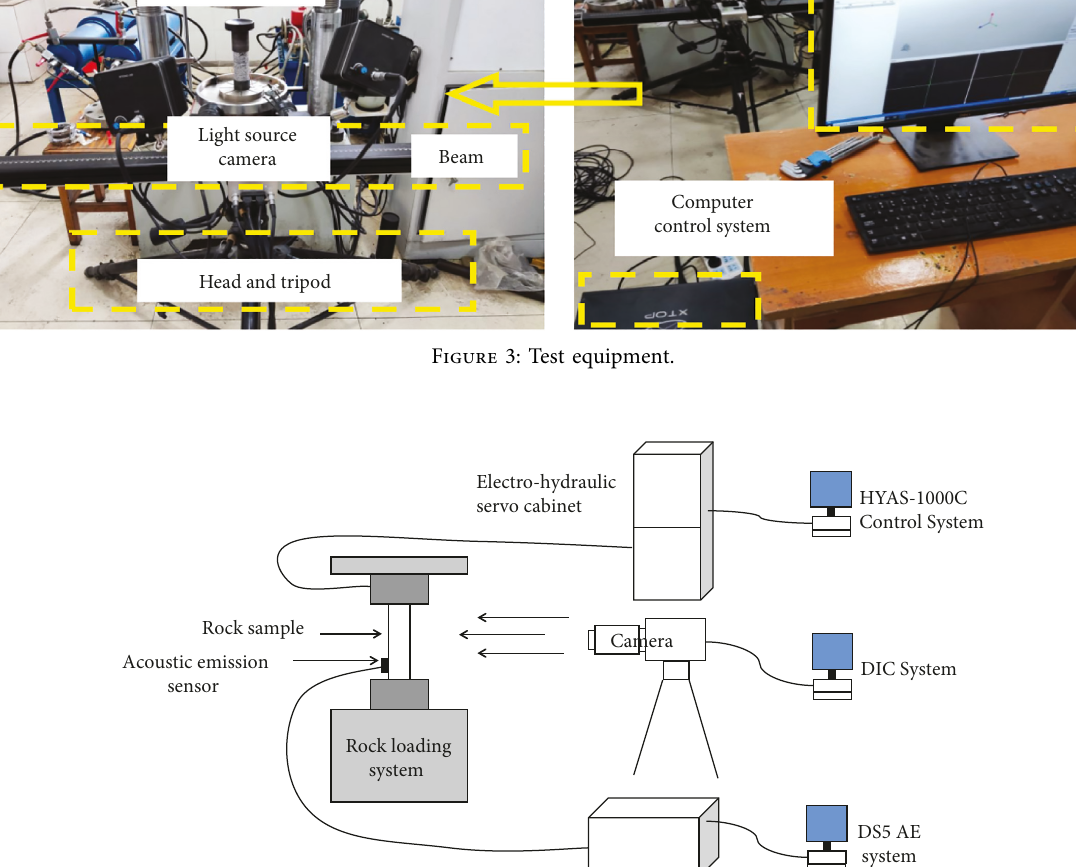
Figure 4: Loading